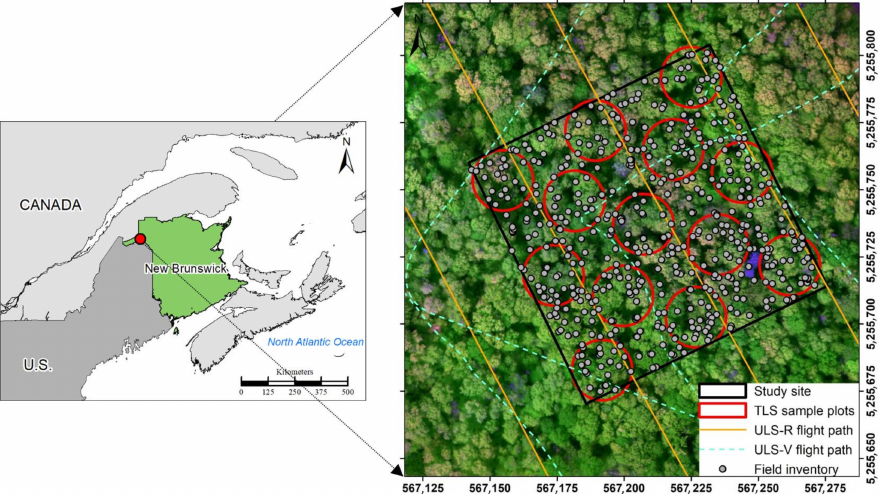
Figure 1. Study site located in McCoy Brook Forest, northeast of Edmundston, New Brunswick, Canada (WGS 1984 UTM-Zone 19N). List of abbreviations: UAV Laser Scanning (ULS) equipped with a Riegl Vux-1LR (ULS-R) sensor and a Velodyne HDL-32E (ULS-V) sensor; Terrestrial Laser Scanning